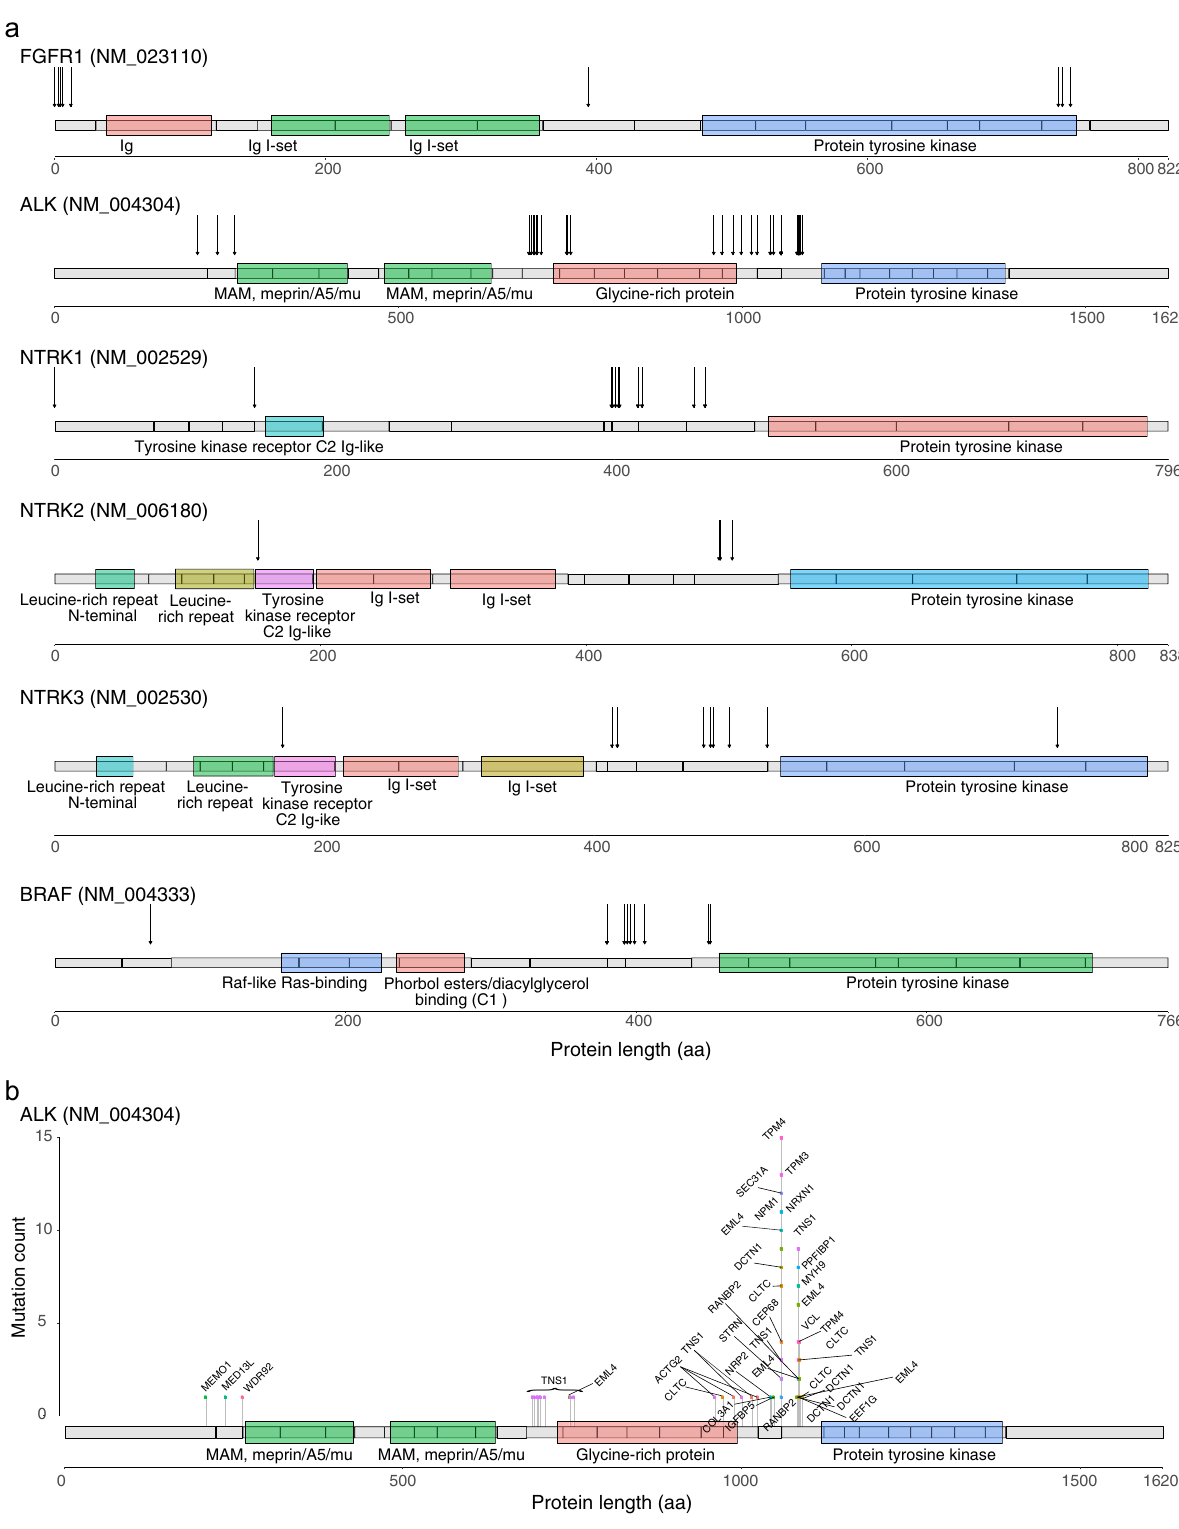
Fig. 3 Gain-of-function kinase gene fusions. a Recurrent kinase gene fusions resulting in activating oncogenes in the kinase domains of FGFR1, ALK, NTRK1, NTRK2, NTRK3, and BRAF. Arrows indicate breakpoints. b Rearrangements that result in activating fusions between TNS1 and ALK,